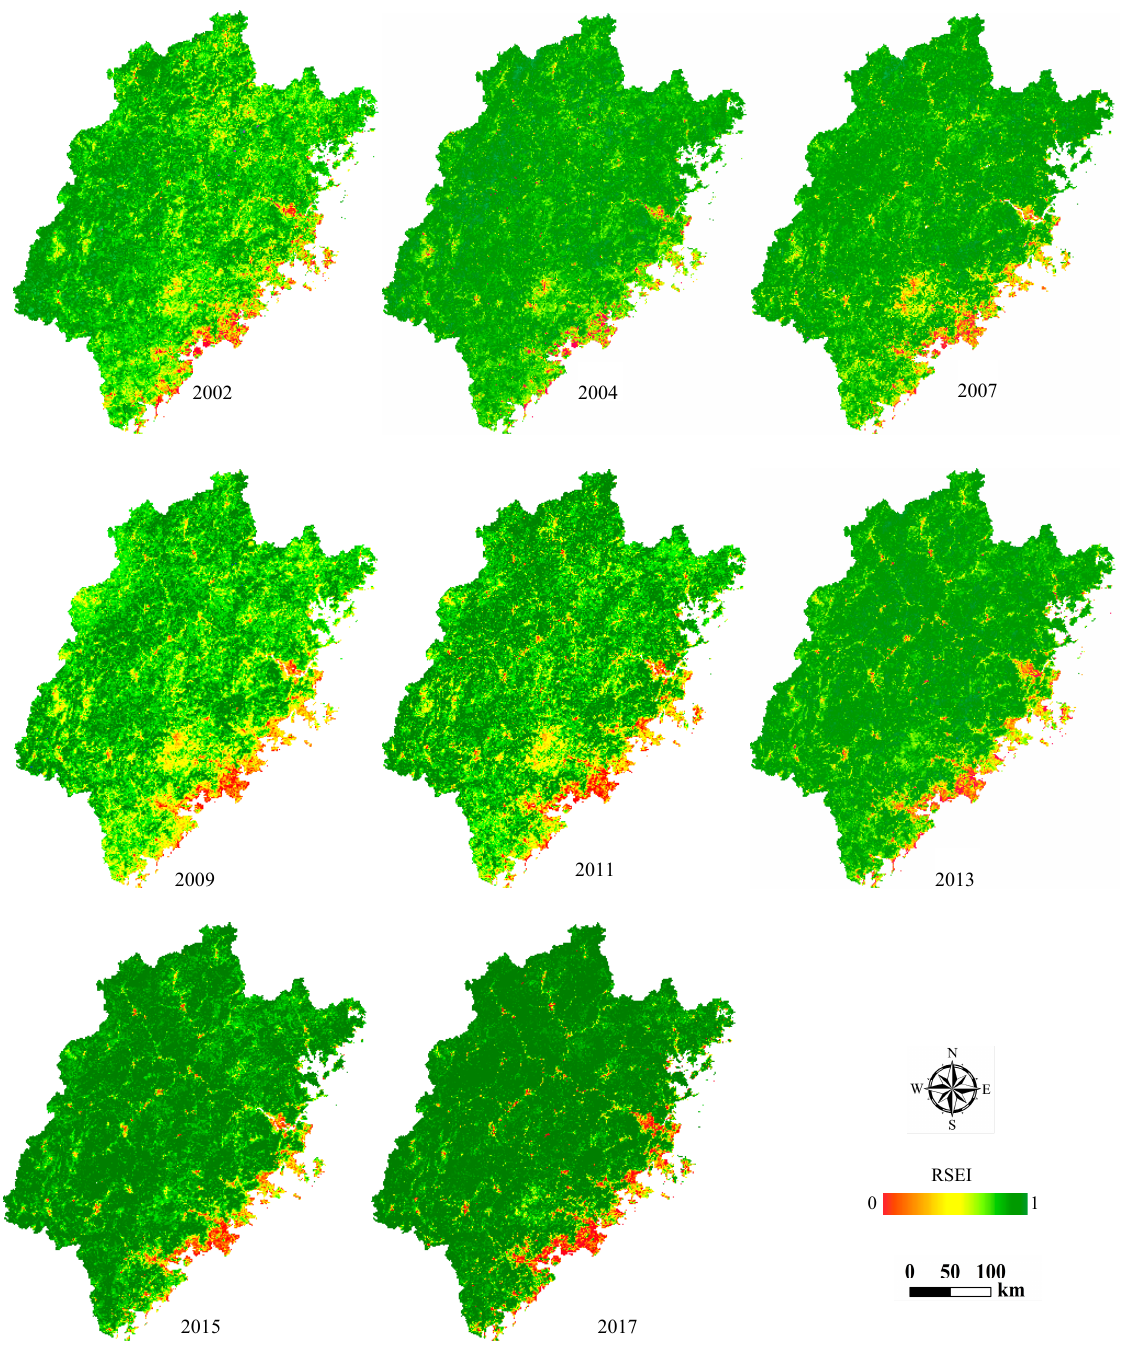
Figure 5. The time series of RSEI images showing the ecological status of Fujian province in each study year and the improvement of the overall ecological condition of Fujian during the study period.